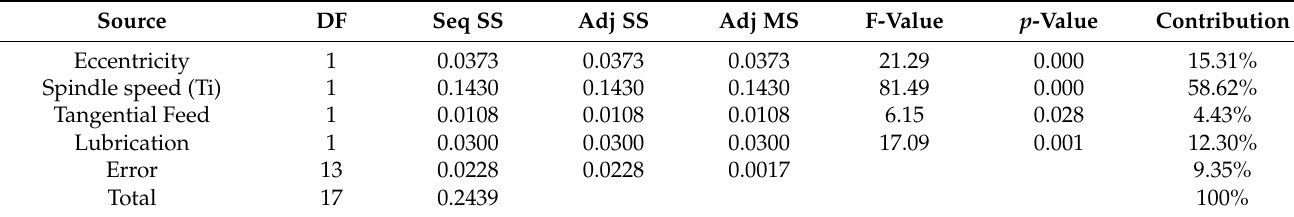
Table 8. Analysis of variance of Ti6Al4V surface